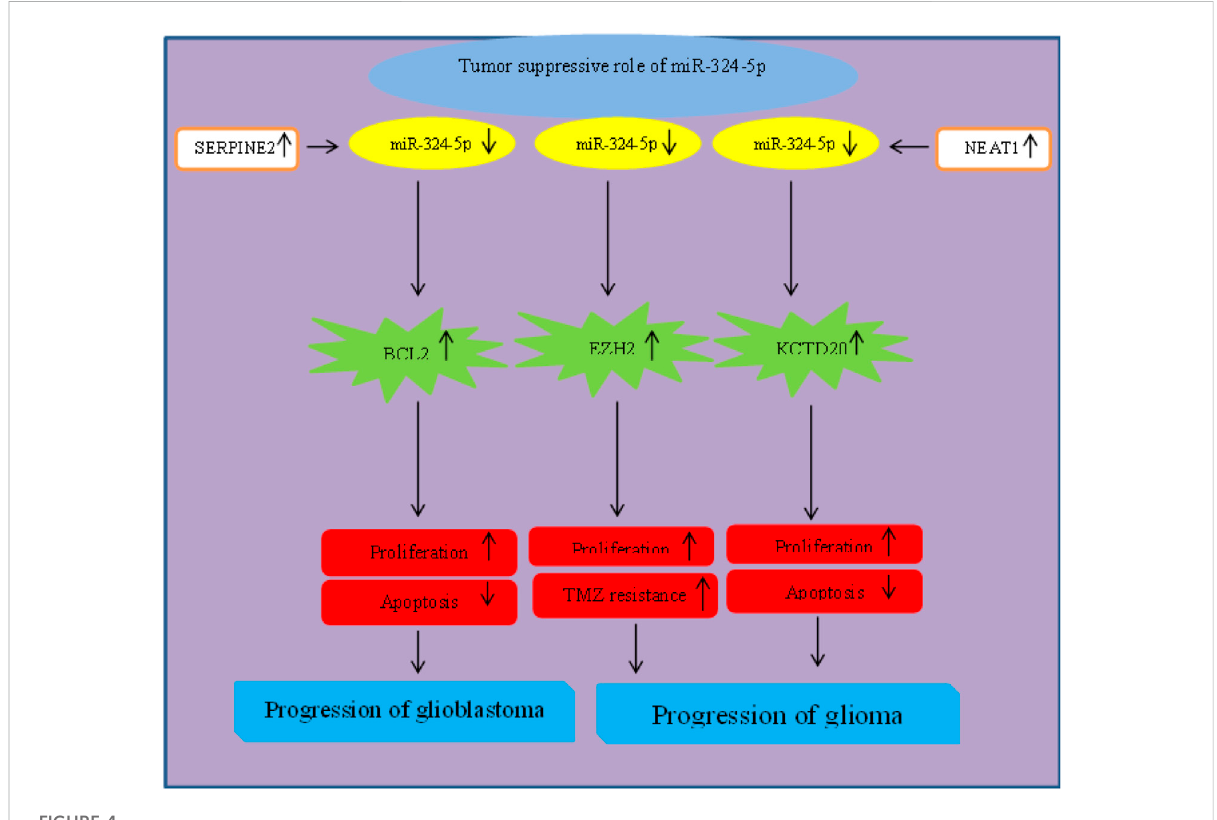
FIGURE 4 Role of miR-324 in progression of brain